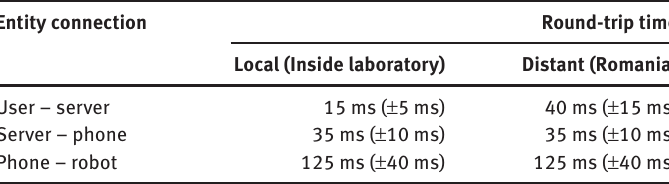
Table 1: Round-Trip Time Related to Entity